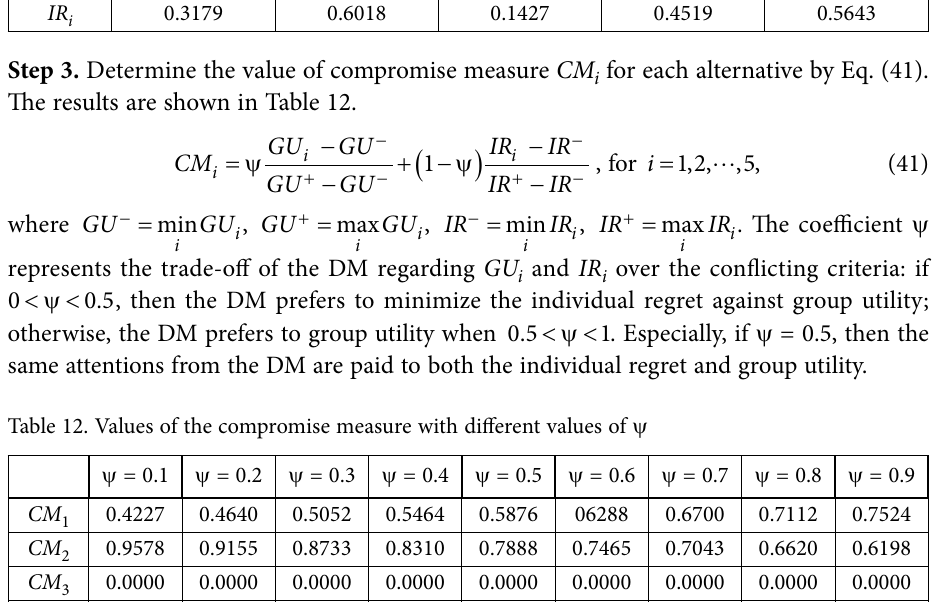
CM 3 0.0000 0.0000 0.0000 0.9265 0.9347 0.9755 0.9837 0.9918 31452